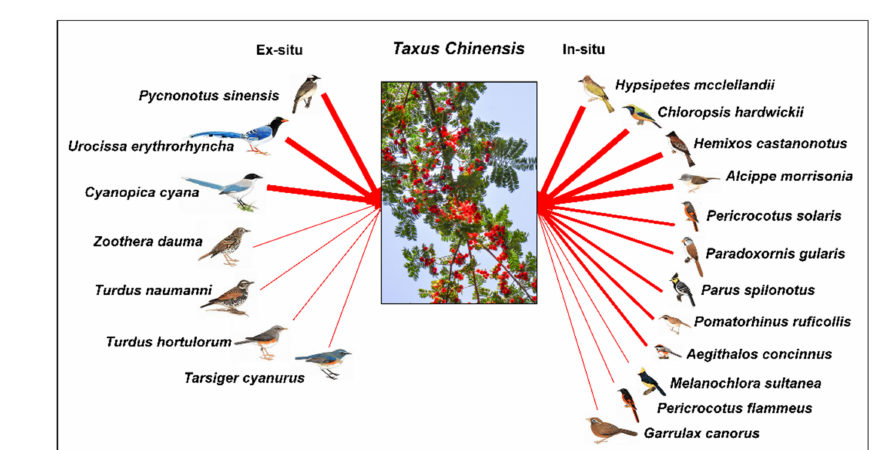
Figure 1. A network approach showing seed dispersal interaction between Taxus chinensis (Pilger) Rehd and frugivorous birds across in-situ and ex-situ sites, Southeast China. Line thickness represents interaction strength, based on the number of seeds removed. Bird pictures are cited from the A Field Guide to the Birds of China [29].